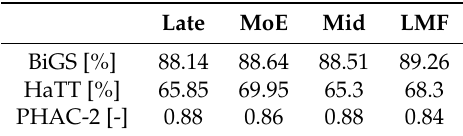
Table 6. Results obtained for models trained on datasets containing noised/zeroed inputs from the leading modality and a noised leading modality channel during tests.